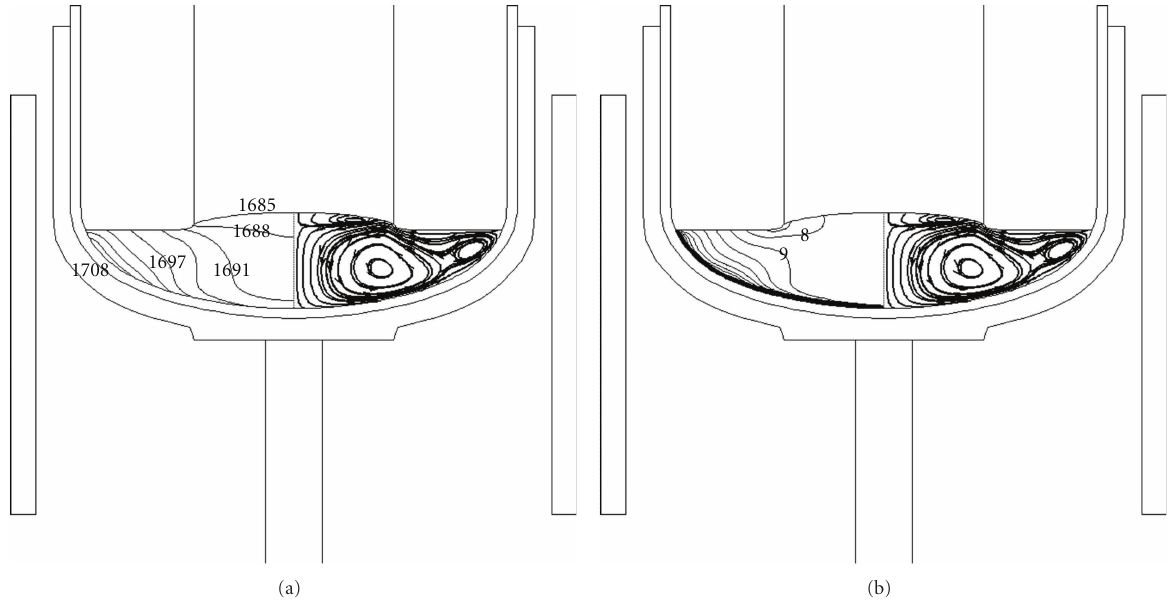
Figure 8: Distribution of temperature, streamtrace, and oxygen concentration in the melt for L = 700 mm in a conventional CZ furnace ( h = 50 mm): (a) isothermal lines (left) and streamtraces (right); (b) oxygen concentration isolines (left) and streamtraces (right). The units of temperature, velocity vector, and oxygen concentration are K, m/s, and ppma, respectively. The spacing of the isothermal lines and concentration isoline are 3K and 1 ppma,